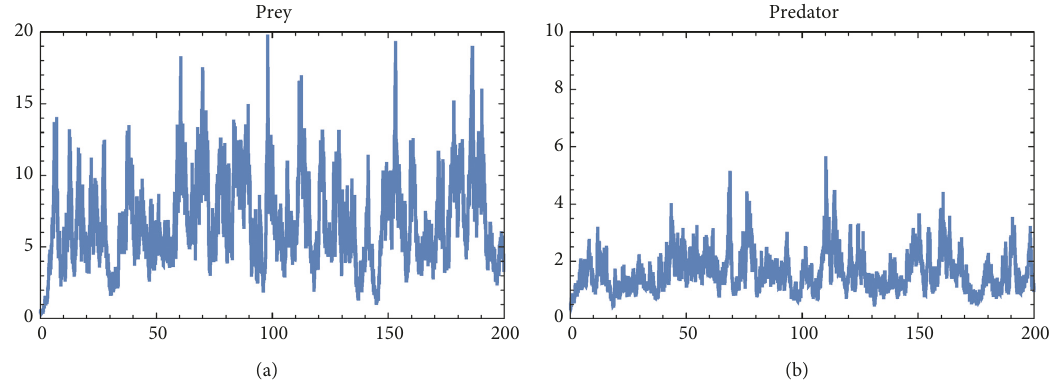
Figure 1: Solution is stochastically permanent if b